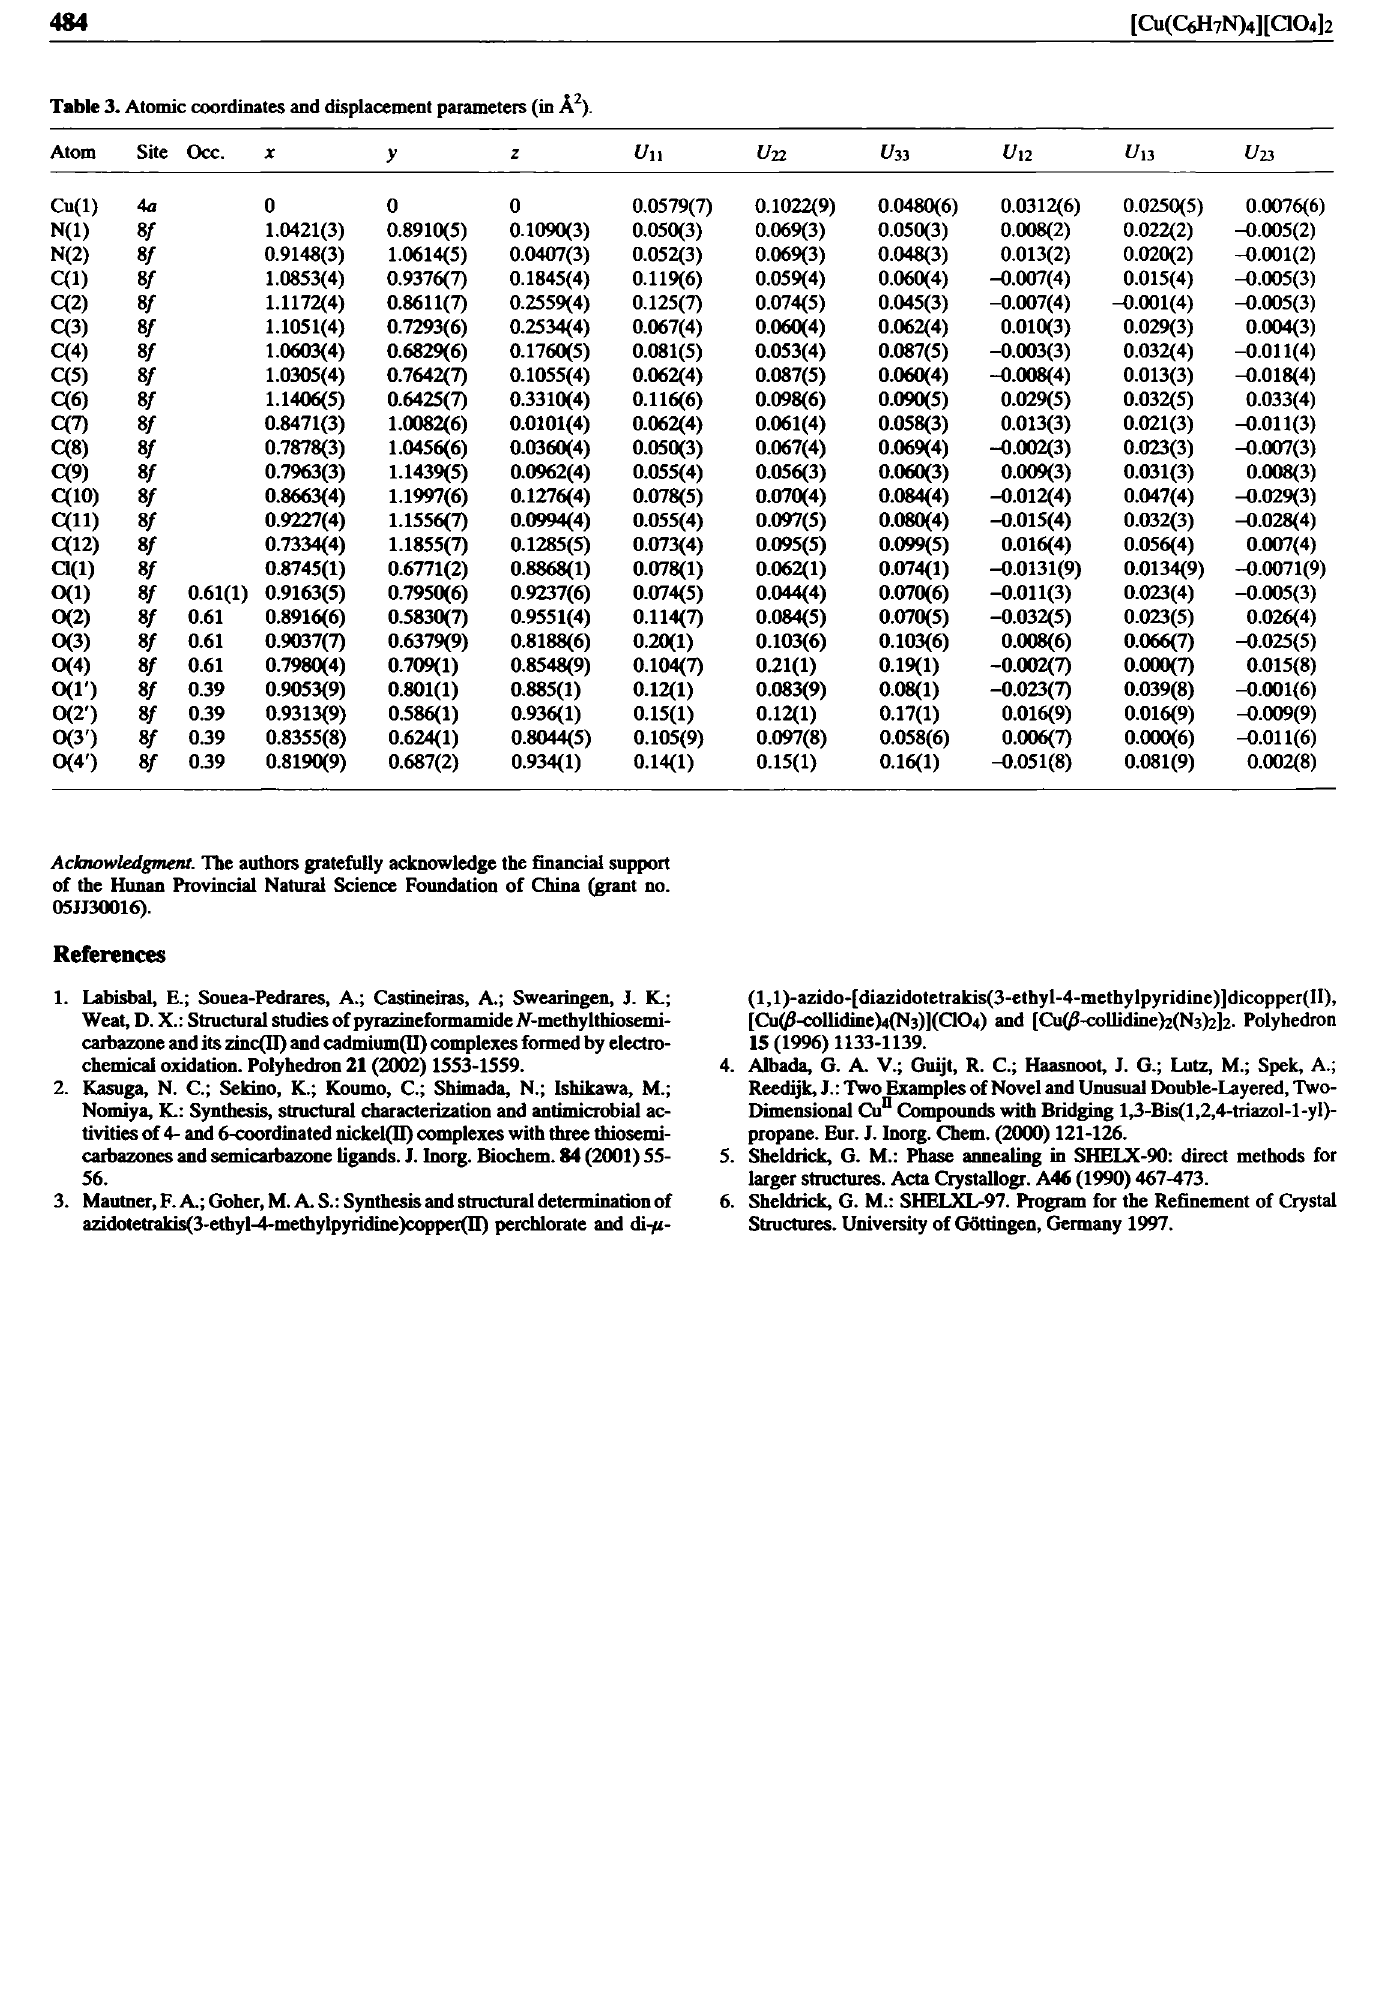
Table 3. Atomic coordinates and displacement parameteis (in A 2